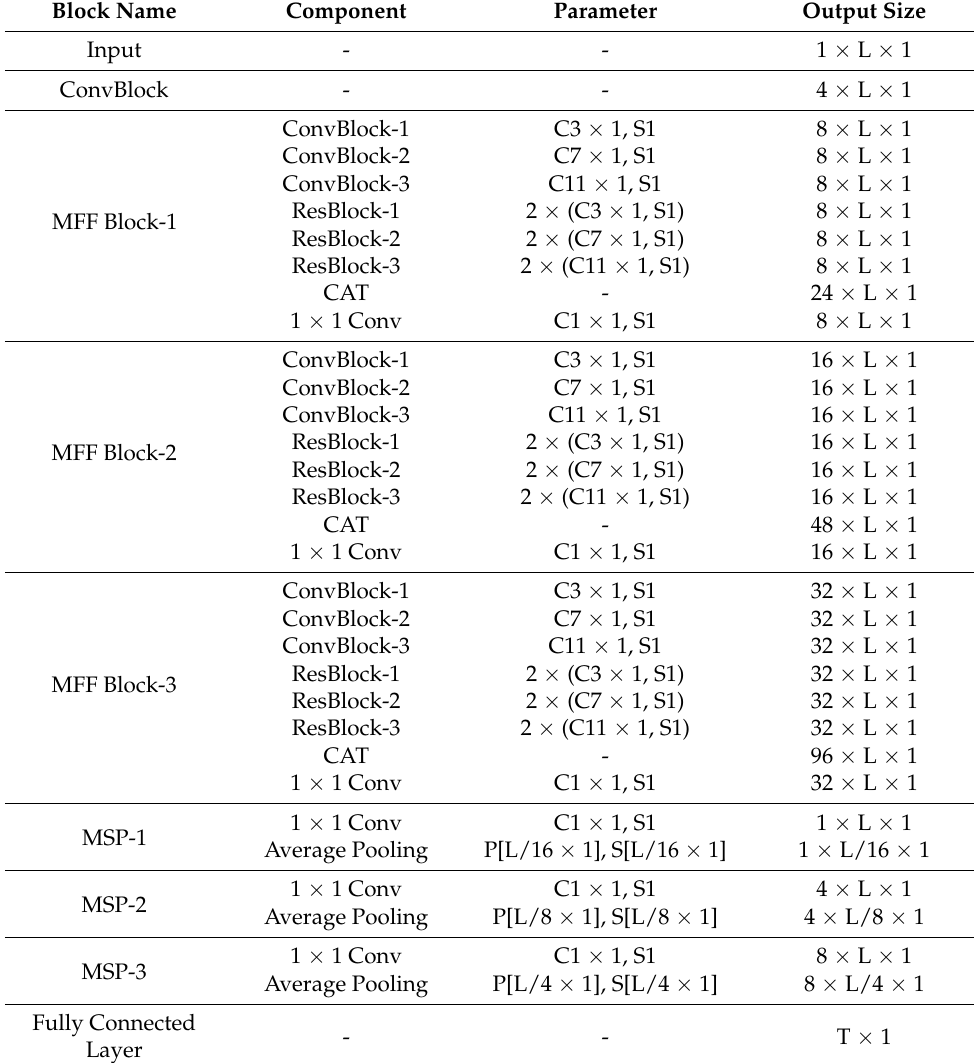
Table 1. The configuration of